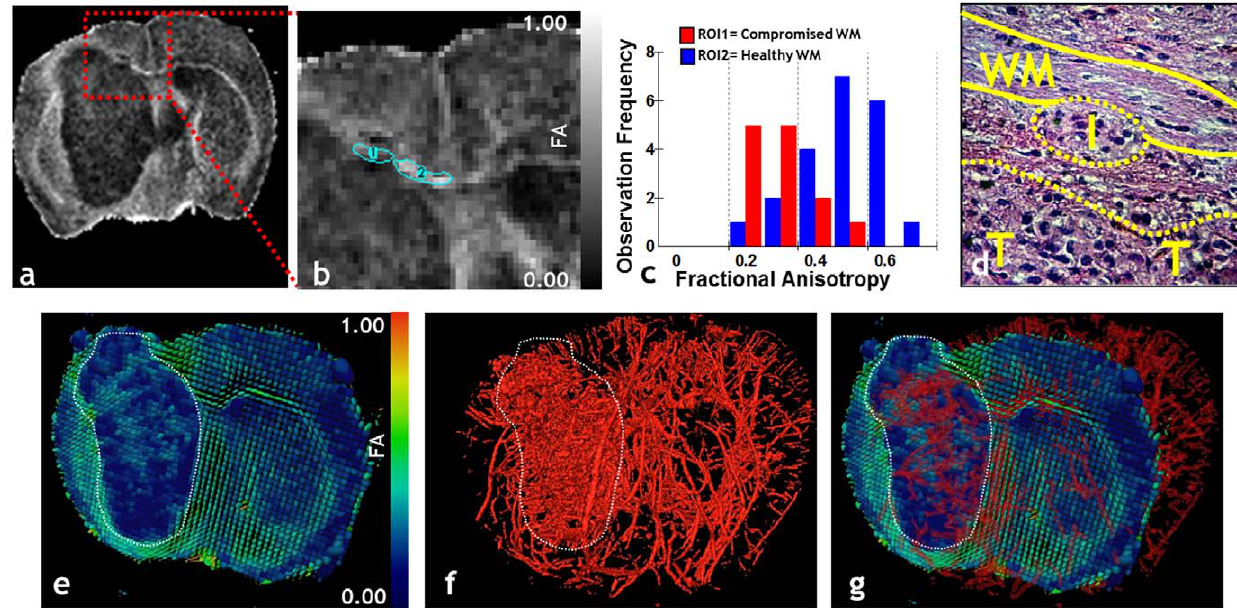
Figure 2. Simultaneous imaging of brain tumor angiogenesis and invasion with m MRI. (a) FA map of a patient-derived, invasive primary glioma model. (b) Zoomed view of the hatched region in (a) showing two ROIs in the corpus callosum for which the FA was analyzed. (c) Histograms of the FA from the ROIs in (b), wherein one can see that the FAs from ROI-1 are shifted toward lower values than those from ROI-2. (d) Histology (H&E) from the same region as in (b) in which one can see the white matter tract (WM) being infiltrated by a tuft of tumor cells (I). The tumor margin (T) is also visible in (d). (e) Visualization of the DTI tensors as 3D ellipsoid glyphs for one m MRI slice, wherein each ellipsoid is scaled according the values of the three principal eigen-vectors and color coded according to the FA. The invasive primary tumor (hatched outline) is identifiable by its lower FA in contrast to the contralateral brain. (f) Visualization of the 3D vasculature for the whole brain. Tumor vasculature (hatched outline) is dense and chaotic relative to that of the contralateral brain. (g) The image in (e) overlaid with that in (f) allows us to simultaneously assess the interaction between brain tumor angiogenesis and the effects of tumor invasion on the integrity of white matter tracts. The tumor ROI is highlighted by a hatched